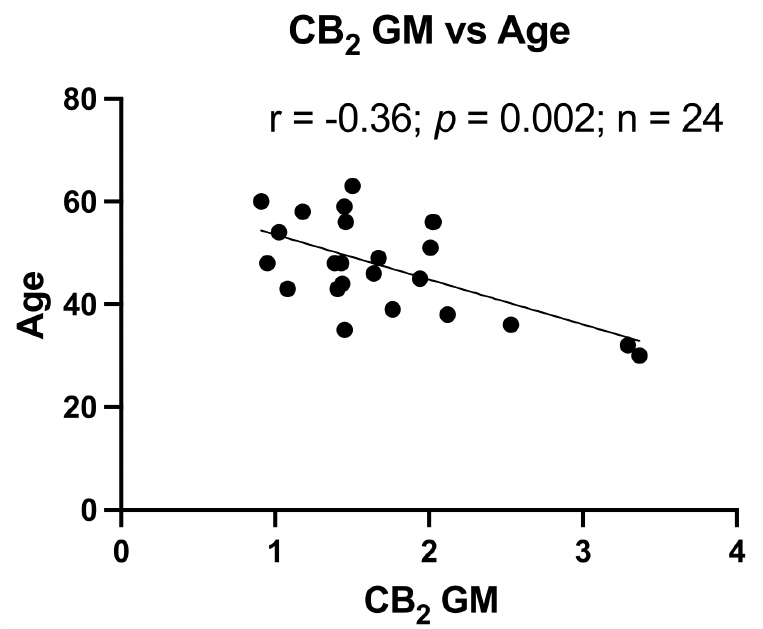
Figure 3. Reduced CB 2 expression relates to increased age. Correlation of CB 2 expression in GM with Age, r = − 0.36, p =